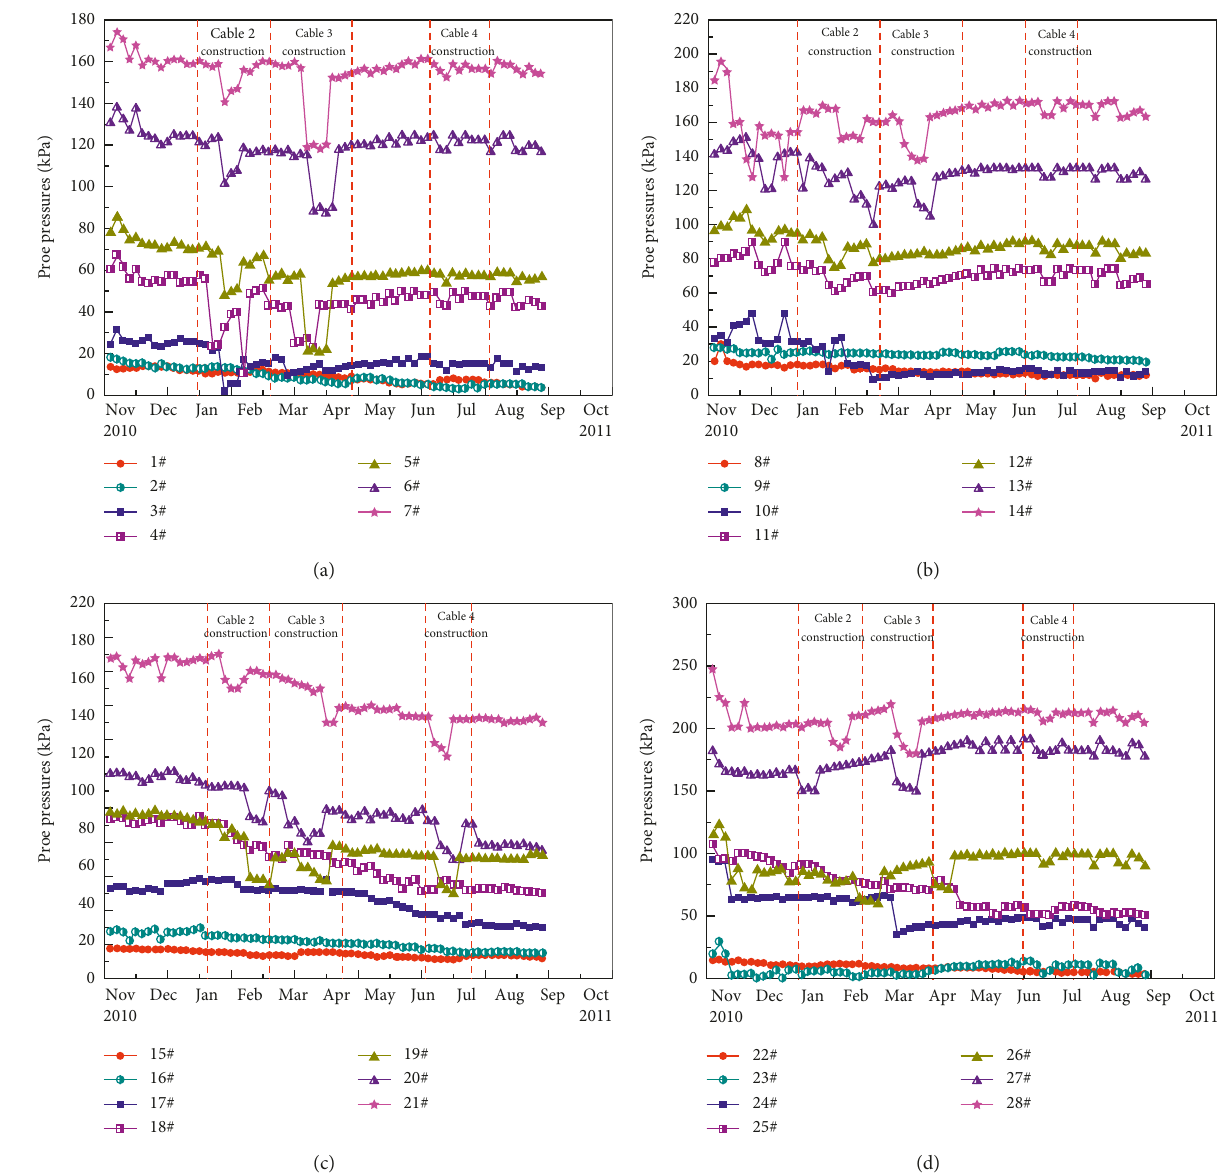
Figure 20: Variation of the pore pressures during construction. (a) The east segment. (b) The north segment. (c) The west segment. (d) The south